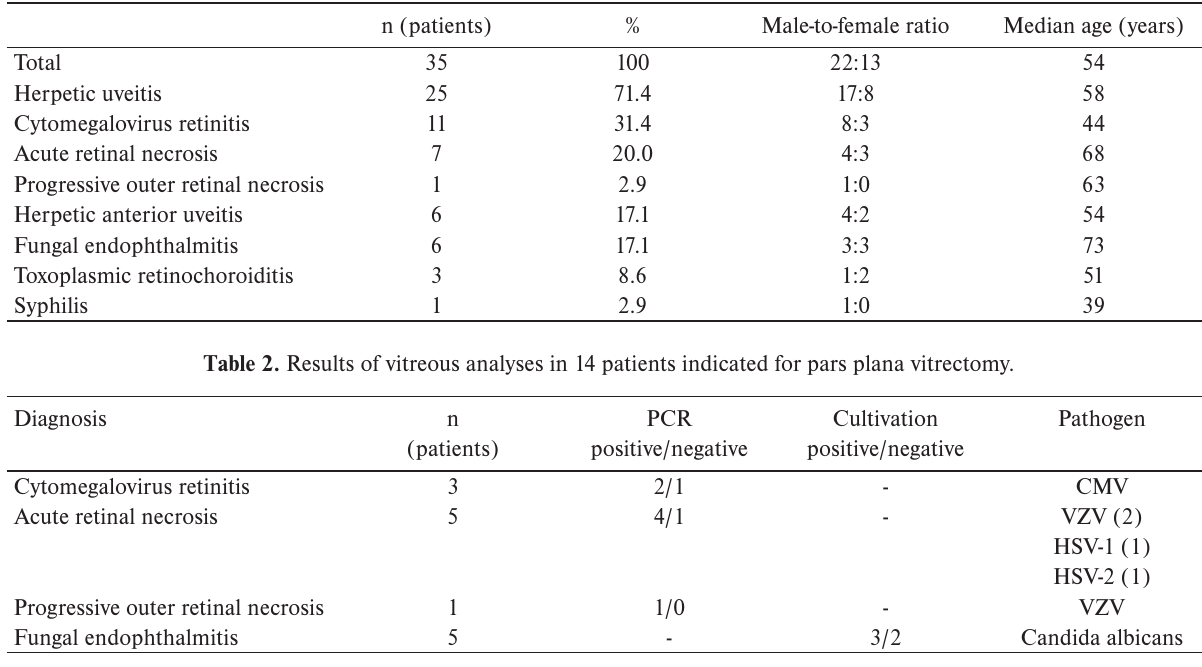
Table 1. Etiological types of infectious uveitis in immunocompromised patients.